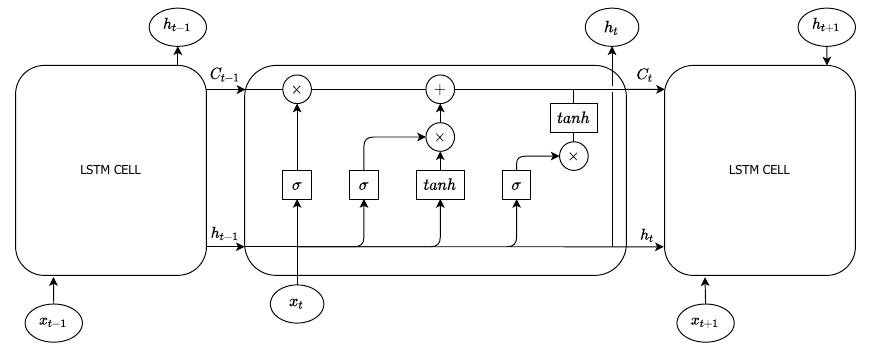
Figure 4. LSTM cell general description.